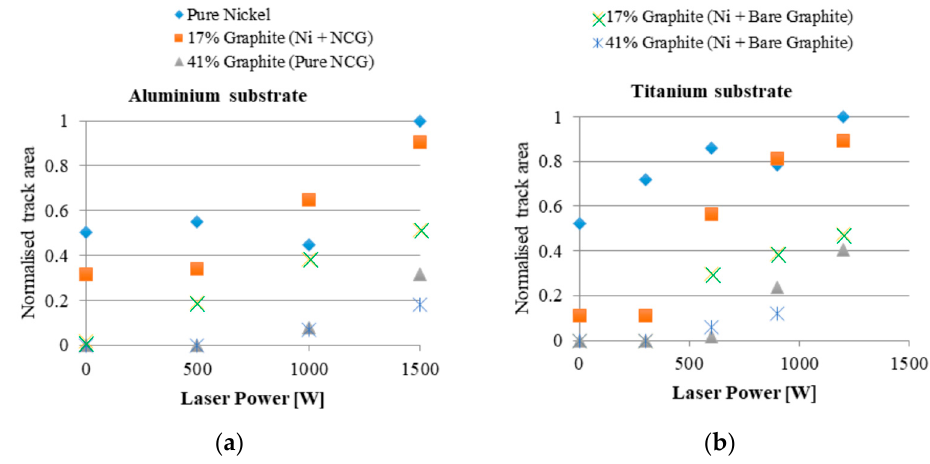
Figure 4. Graphs showing track cross sectional area vs. laser power for various feedstock composi- tions on both aluminium ( a ) and titanium ( b ) substrates at a traverse rate of 60 mms − 1 . Micrographs of single lines deposited onto aluminium with 1500 W laser power us- ing pure nickel, nickel/graphite, and nickel/NCG, depicted in Figure 5, show that although the nickel/graphite mixture has deposited, no graphite is visible. This contrasts with the nickel/NCG deposit, where graphite inclusions are observed.